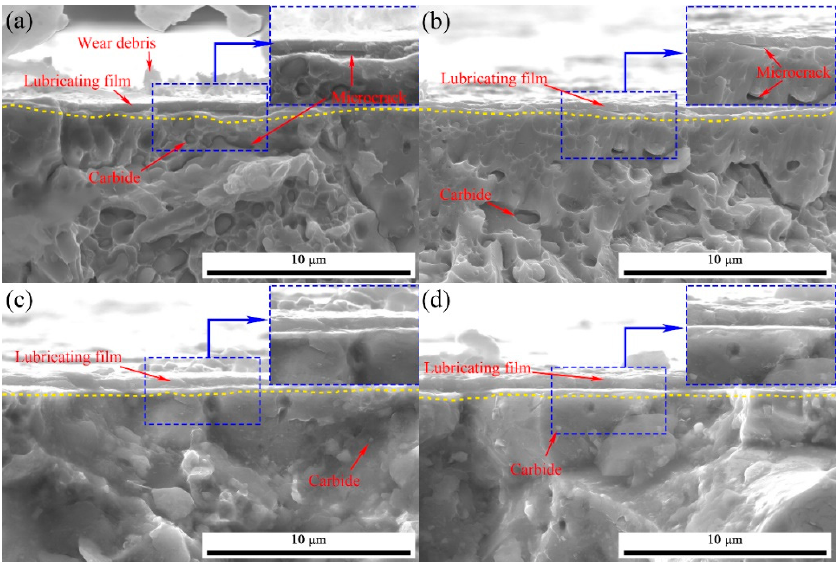
Figure 8. Typical wear scar morphology of cross sections of the Blank/10 specimen ( a ), CRR/10 specimen ( b ), Blank/20 specimen ( c ), and CRR/20 specimen ( d ).